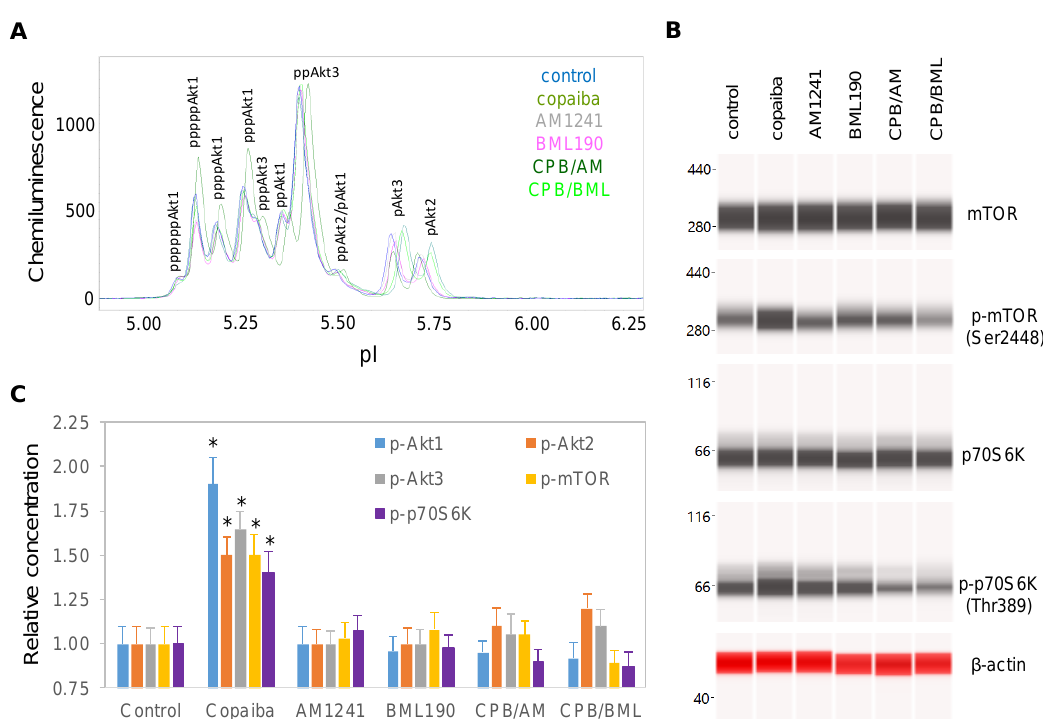
Figure 4. CB2 agonists abrogated the activation of the PI3K / Akt / mTOR signaling pathway by copaiba essential oil. ( A ) Pan-Akt profiles and ( B ) expression levels of the mTOR and p70S6K phosphoisoforms in SH-SY5Y cells at 30 min following treatment with copaiba essential oil (100 ng / mL), AM1241 (200 nM), BML190 (10 µ M), 100 ng / mL copaiba essential oil together with 200 nM AM1241 (CPB / AM), or 100 ng / mL copaiba essential oil together with 10 µ M BML190 (CPB / BML). ( C ) Relative concentrations of the Akt1 (blue), Akt2 (orange), Akt3 (gray), mTOR (yellow), and p70S6K (purple) phosphoisoforms in SH-SY5Y cells at 30 min following treatment with copaiba essential oil, AM1241, BML190, CPB / AM, or CPB / BML. The relative concentration describes the fold change in a protein phosphoisoform after treatment compared to the control condition. The error bars are the standard deviations of six repeated measurements per experimental condition. The asterisks indicate statistical significance for p ≤ 0.05 versus the control.